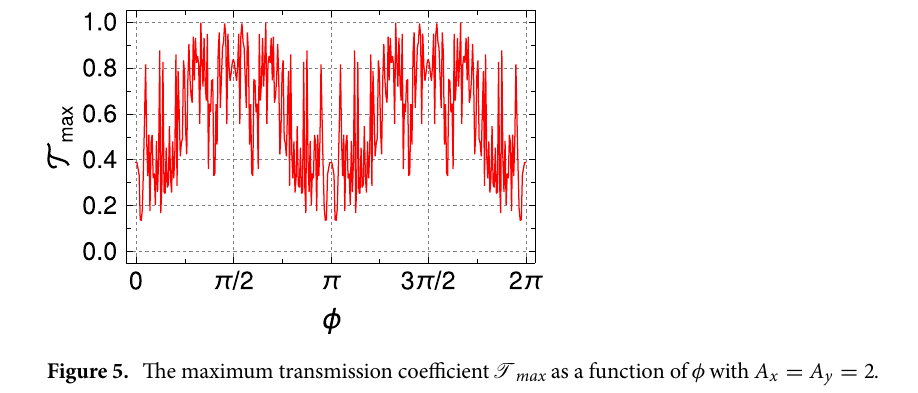
Figure 5. The maximum transmission coefficient T max as a function of φ with A x